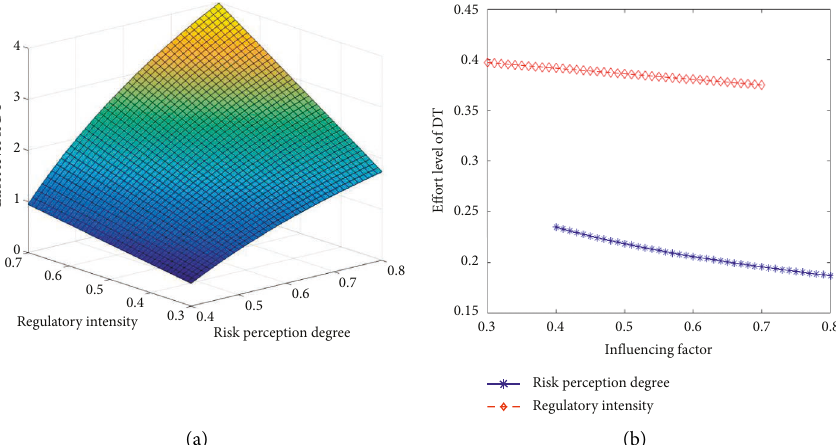
Figure 2: Effect results of risk perception degree and regulatory intensity on the effort level of DT. (a) The scenario result of array II. (b) Scenario results of array III and array